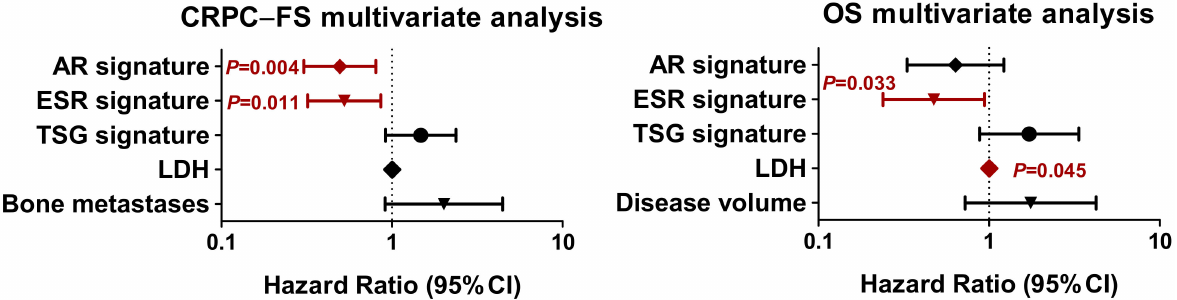
Figure 6. Multivariate analysis for androgen receptor (AR), estrogen receptor (ESR) and tumor suppressor gene (TSG) signatures. Forest plots represent the multivariate analysis of AR, ESR and TSG signatures for CRPC-free survival (CRPC-FS) and overall survival (OS). LDH: lactate dehydrogenase; HR: hazard ratio; CI, confidence